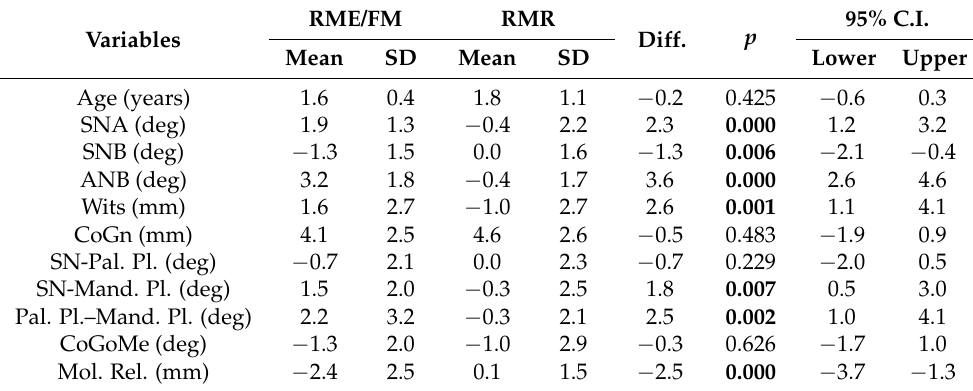
Table 3. Descriptive statistics and statistical comparisons (independent sample t test) for the T1– T2 changes. Variables